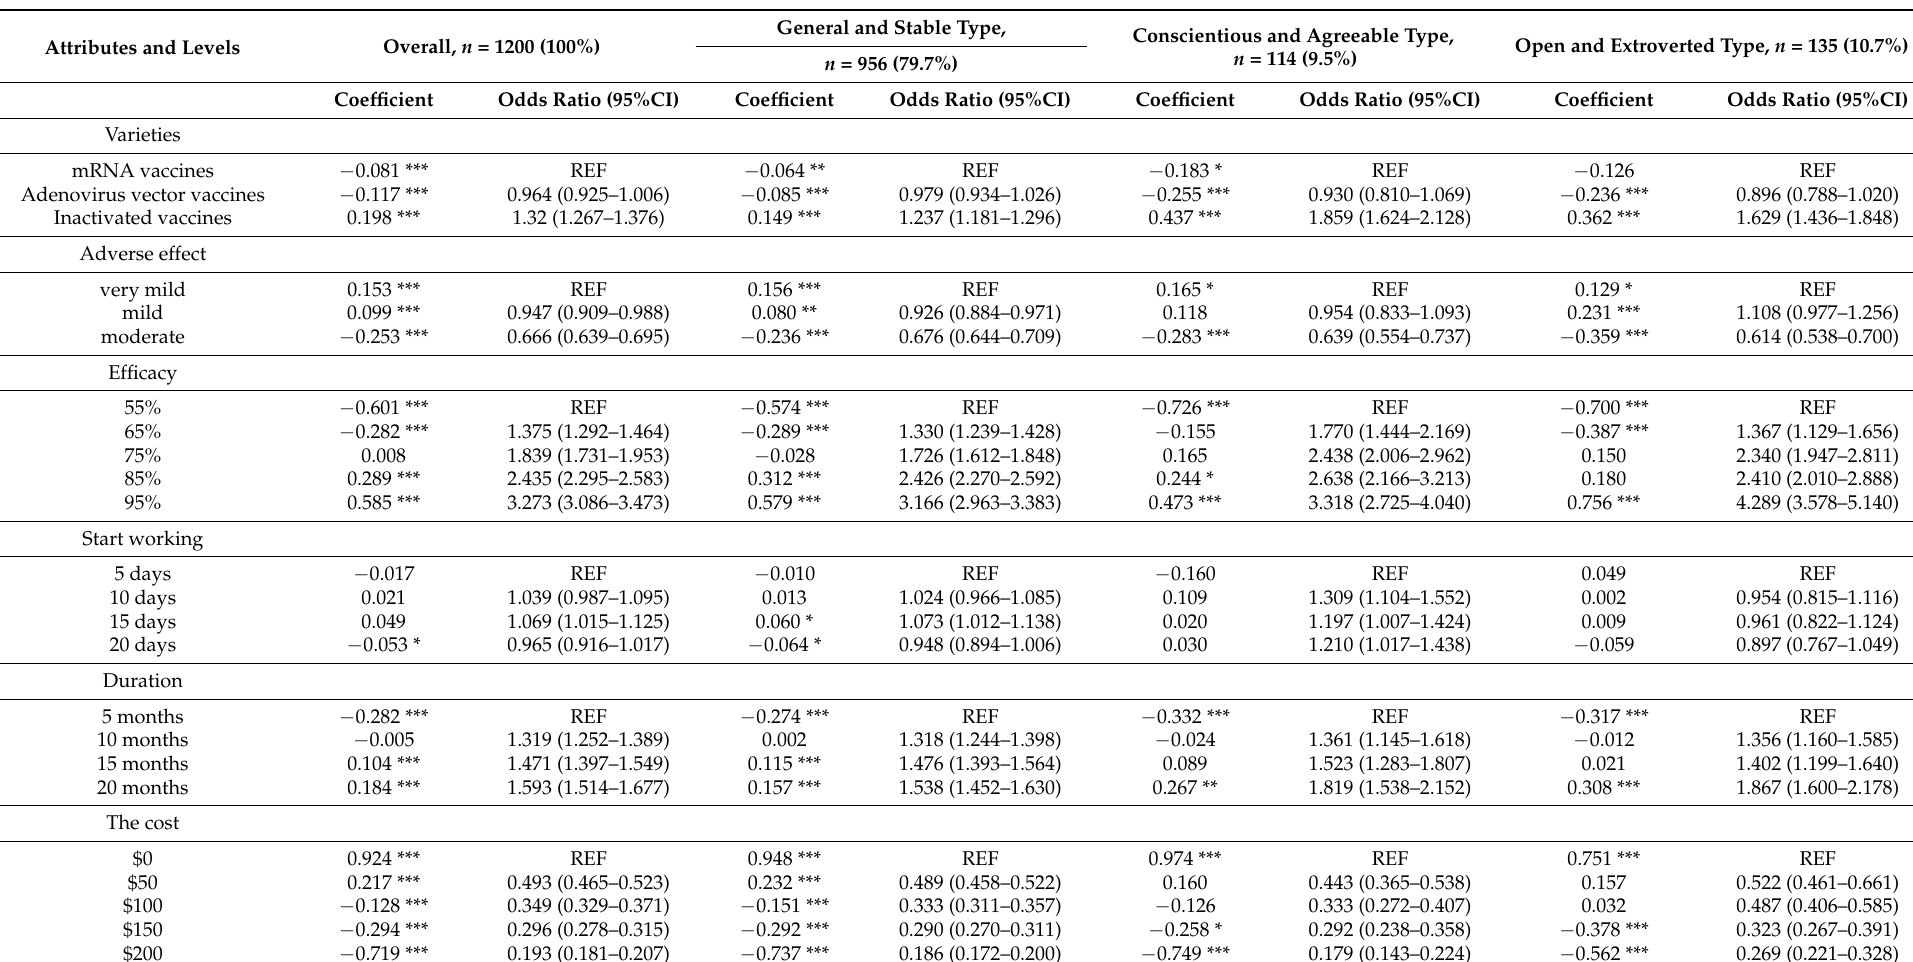
Table 5. General results of the conditional logit model. Comparison of overall and three categories of respondents with different personality traits in attributes levels utility and odds